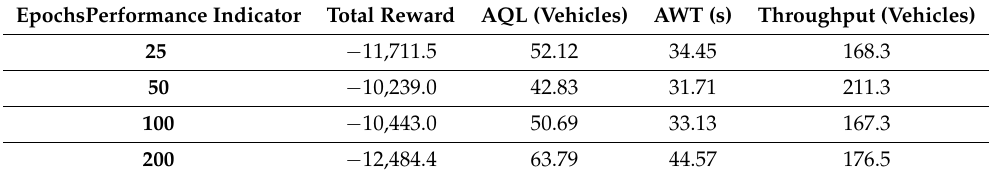
Table 8. Average performance of model trained with different number of epochs using action time step 0.5 s.